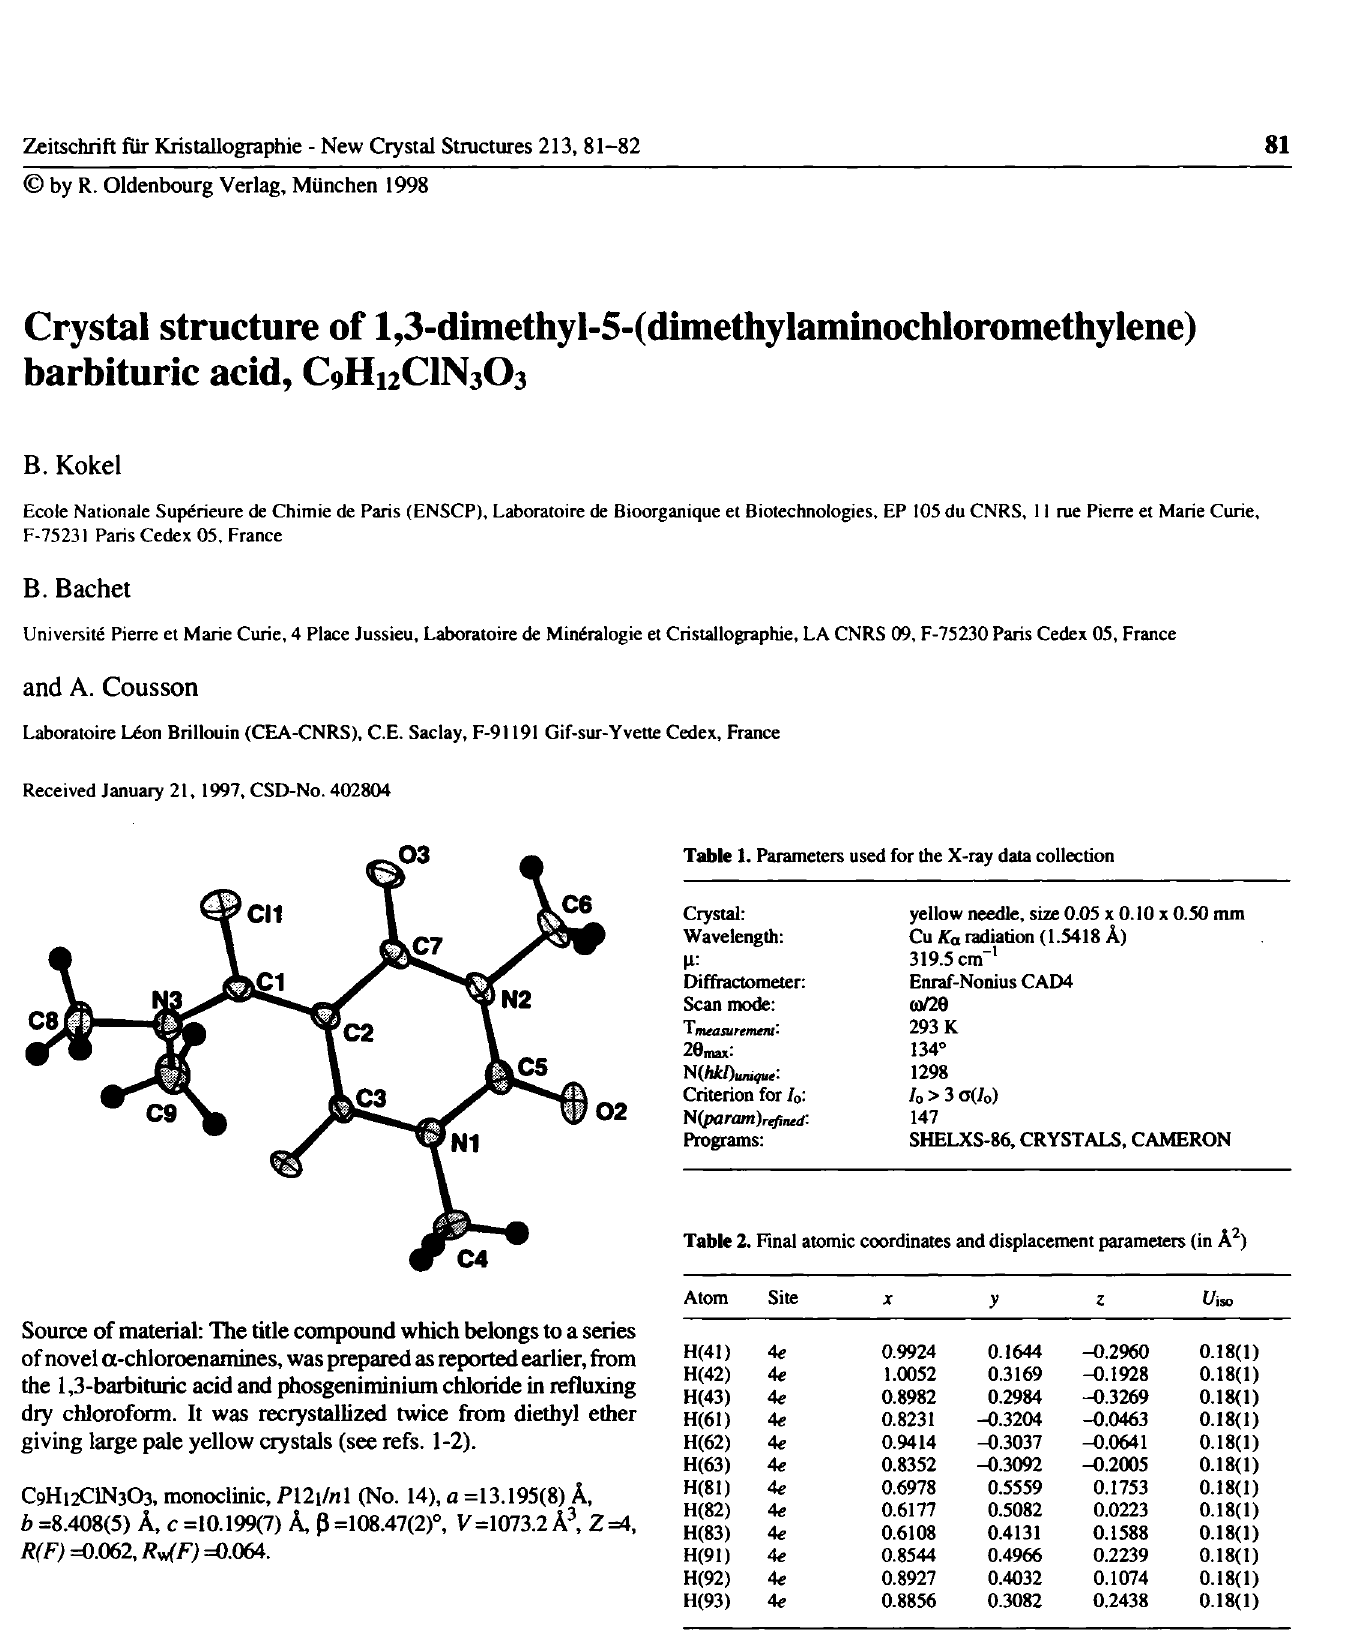
Table 3. Final atomic coordinates and displacement parameters (in A^) Atom